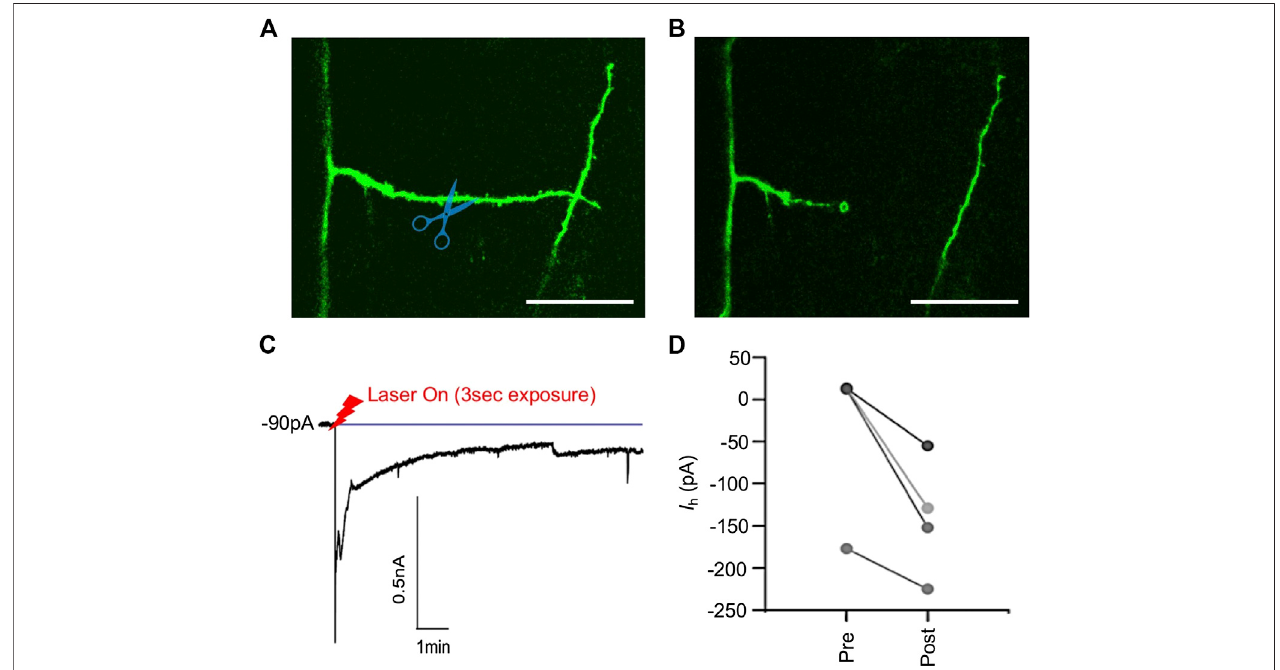
FIGURE 5 | Laser dendrotomy of apical oblique dendrites. Fluorescence image of an oblique branch (A) before dendrotomy, and (B) after dendrotomy, (C) the currentrecordingatthesoma.Afterdendrotomy,thecurrentincreasedsharplyindicatingAP fi ringoftheneuron.Thecurrentthendecayedtoanewvalueafter10 minas membraneat thecutsitepartiallysealed, (D) theholding currentbefore (Pre)and after(Post) dendrotomy required tomaintainthemembrane potential at − 65 mV.Scale bars in (A) and (B) are 10 µm.